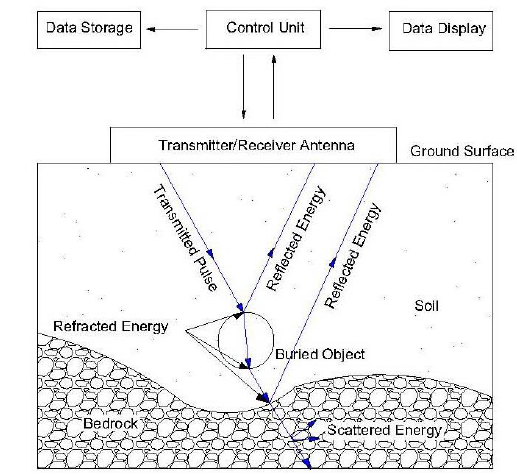
Figure 1: Functional diagram of GPR equipment